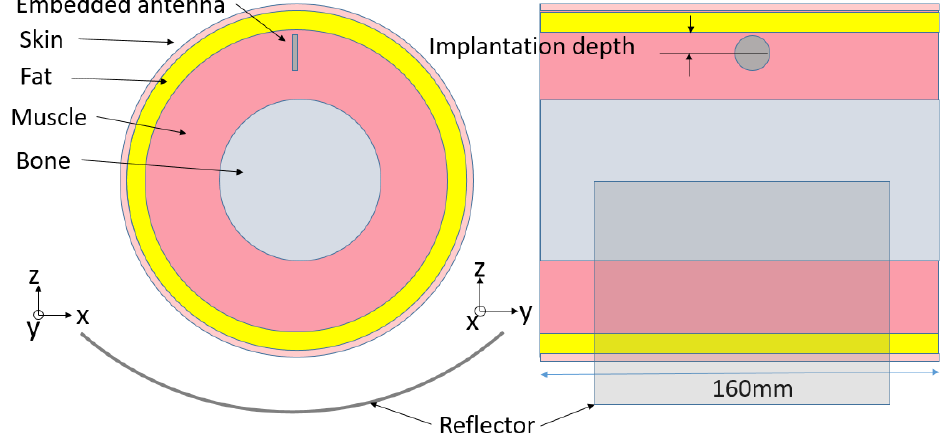
Figure 1. Power transmission link design. Table 1. Dielectric constants of human tissue.